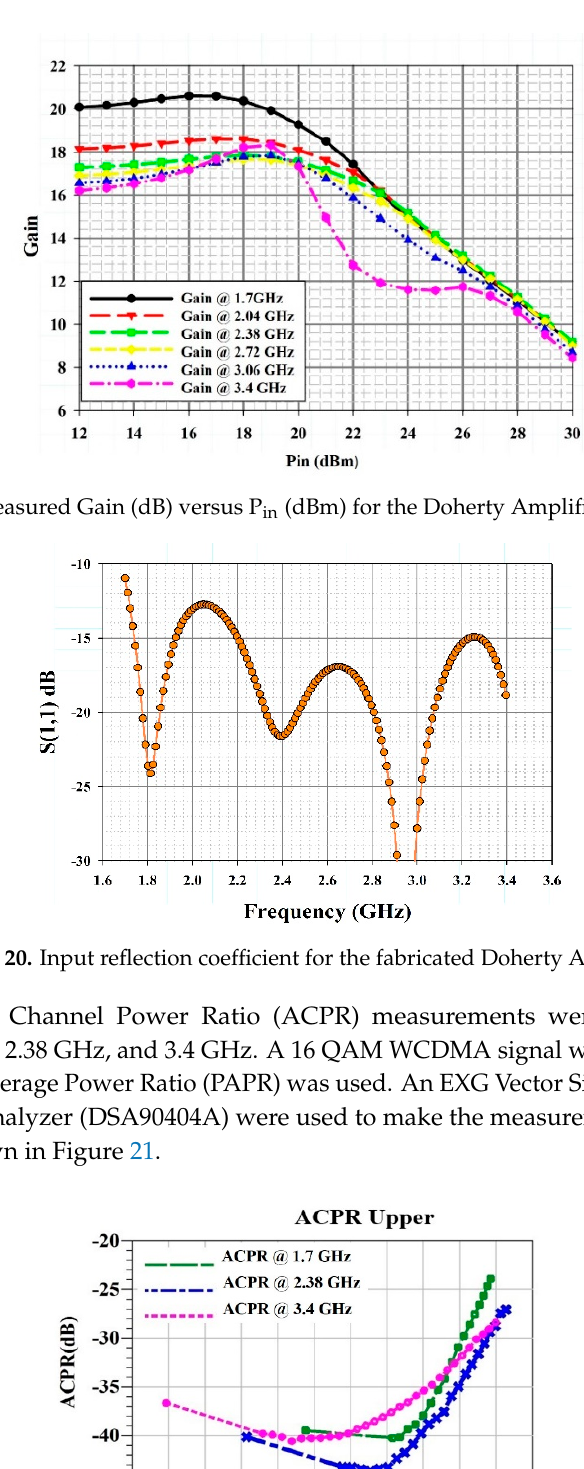
Figure 18. Measured drain efficiency at 6 dB OPBO and output power saturation for frequencies between 1.7 GHz and 3.4 GHz.